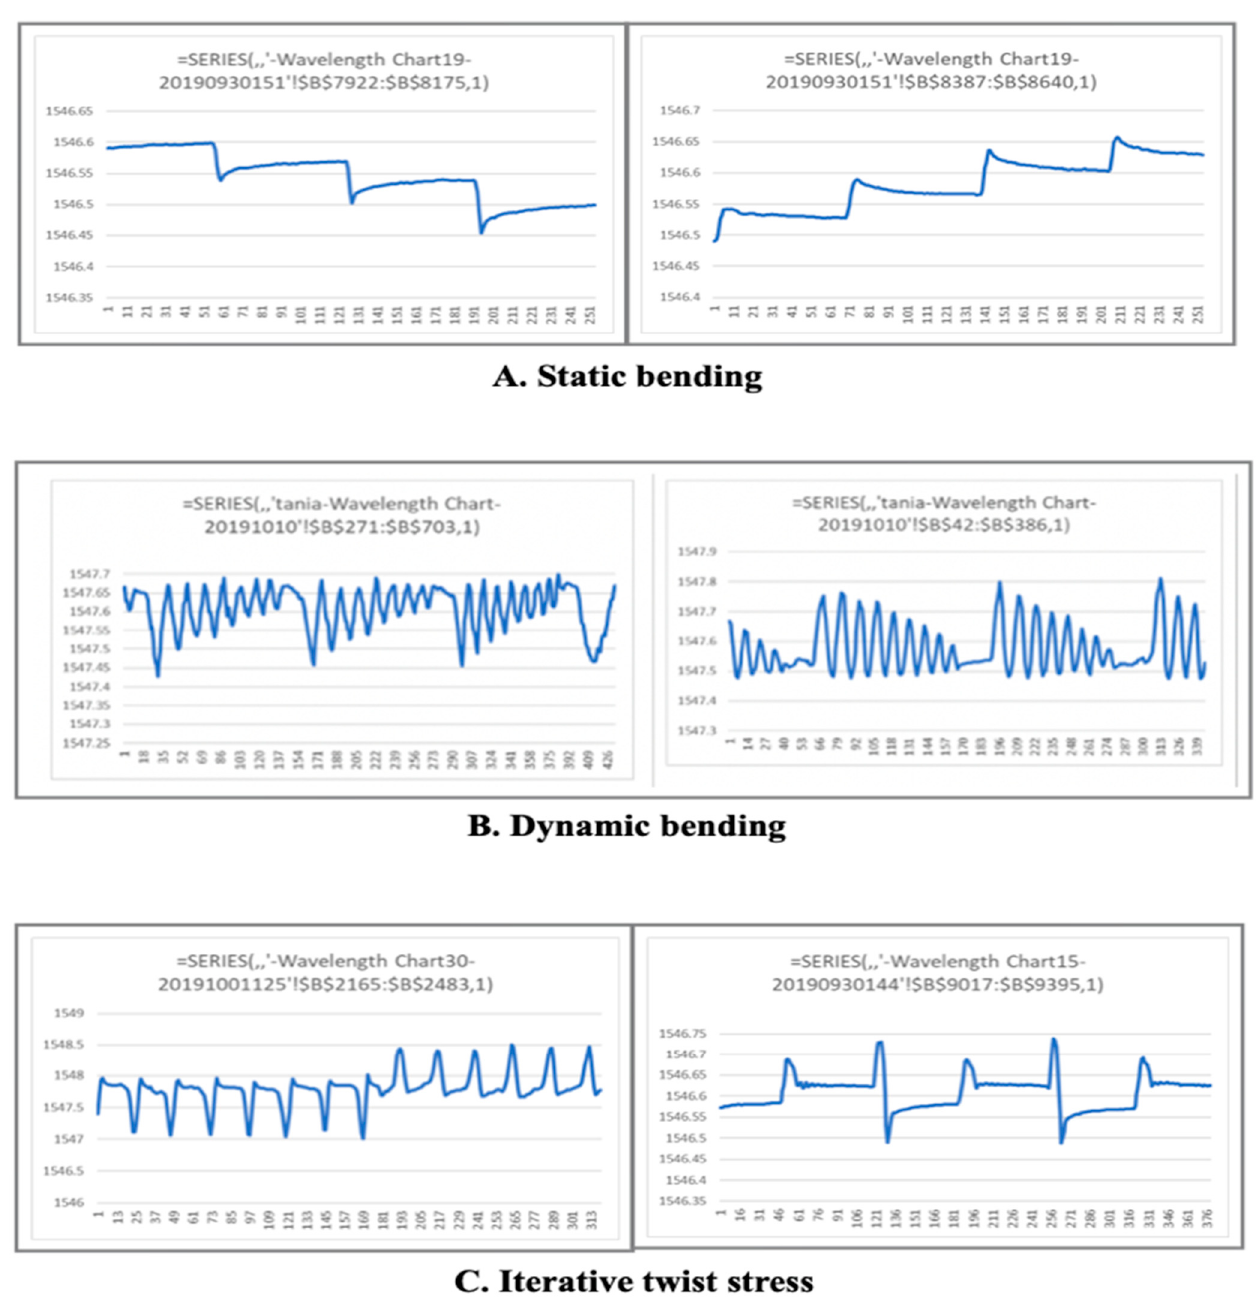
Figure 10. ( A ). The morphology of the wavelength shift when strain decreases and increases in static steps (picosecond); ( B ). Continuous stepwise strain reduction and increase in the wavelength shift morphology; and ( C ). Wavelength shift pattern morphology of clockwise and counterclockwise directional stress–strain.